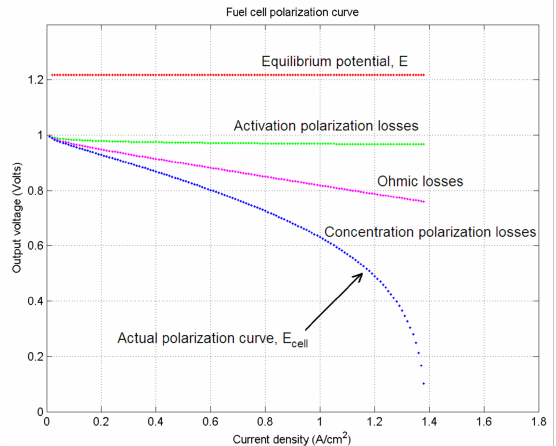
Figure 13. The polarization curve and various potential losses in the